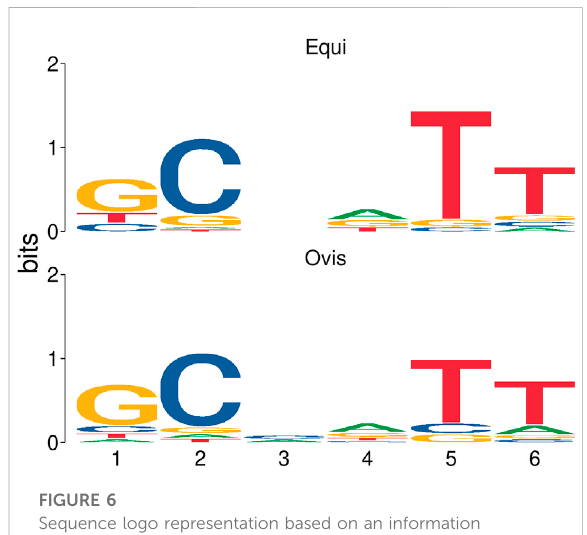
FIGURE 6 Sequence logo representation based on an information content matrix comparison between ovis and equi microsatellite biovars. In this fi gure, we can see the difference in position 3 and the similarities in the other positions when comparing the two sets of microsatellites by usingthe information content matrix